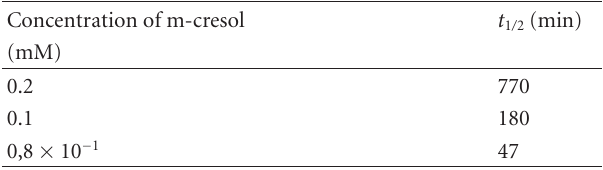
Table 1: Half-lives of m-cresol in various initial concentrations. Concentration of